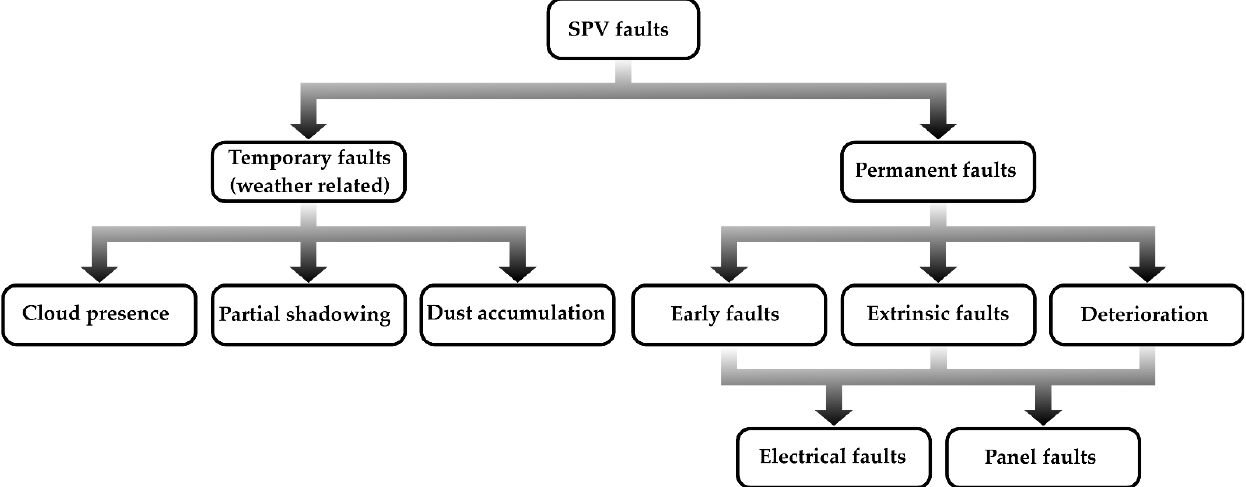
Figure 1. Type of faults in SPV systems. Table 1. Common faults in SPV system and their description. Temporary Faults (Weather Related)